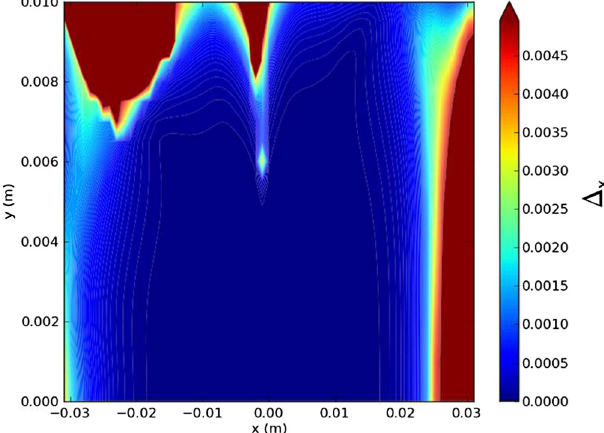
FIG. 11. Δ in the xy plane color scaled by the rms x